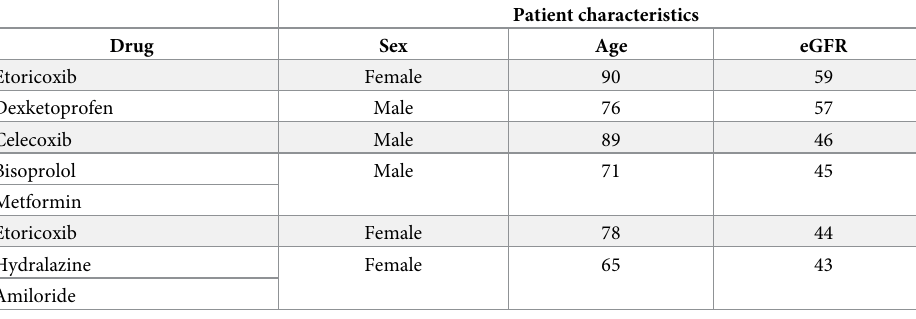
Table 7. Detail of the medications that were discontinued and the patients who used them.